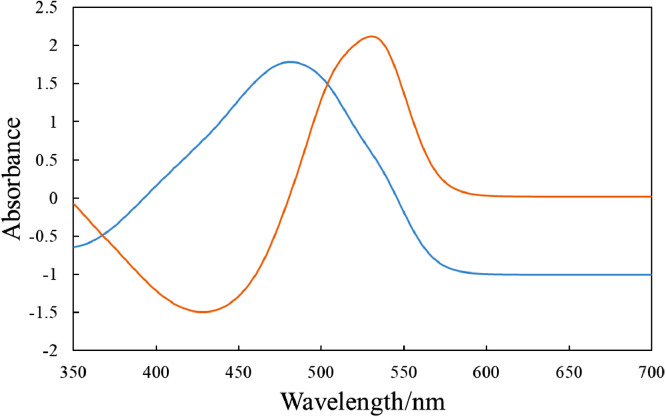
The loading spectra obtained by PCA of the spectra shown in Fig. 2.